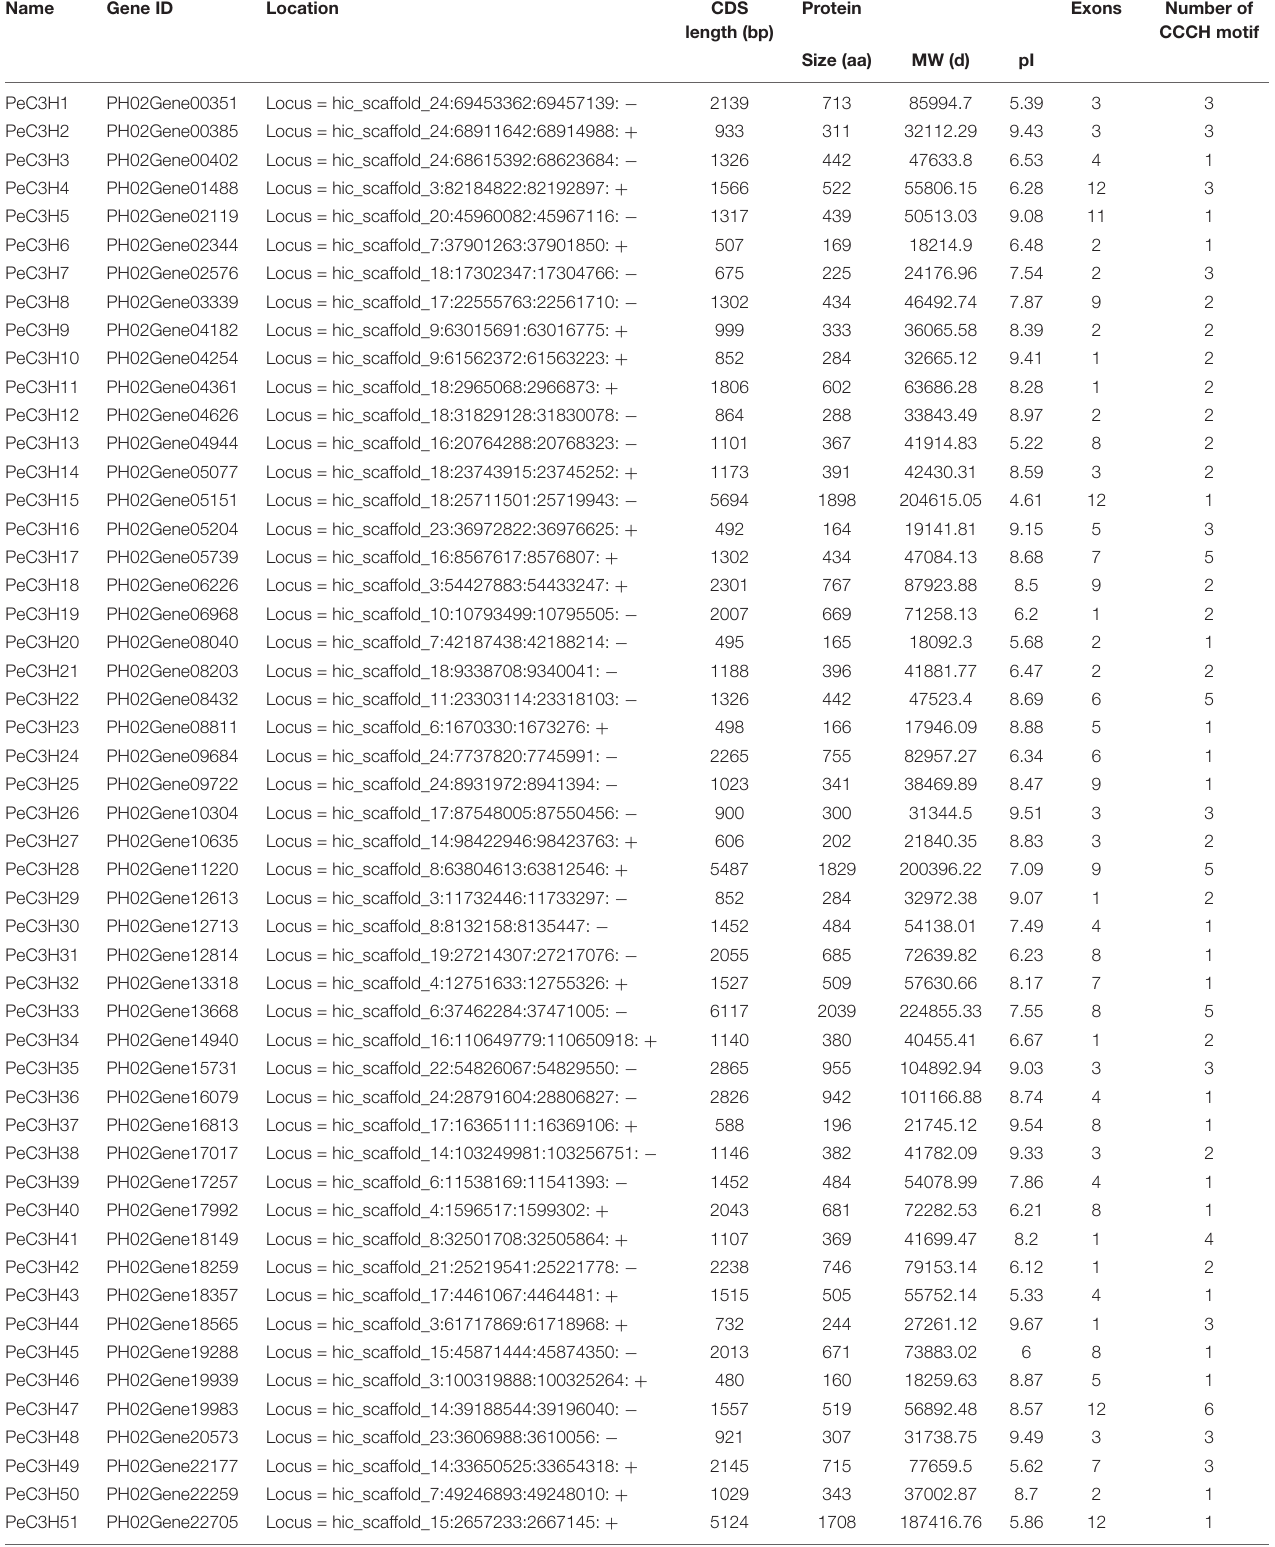
TABLE 1 | Detailed information on conserved amino acid sequences and motif